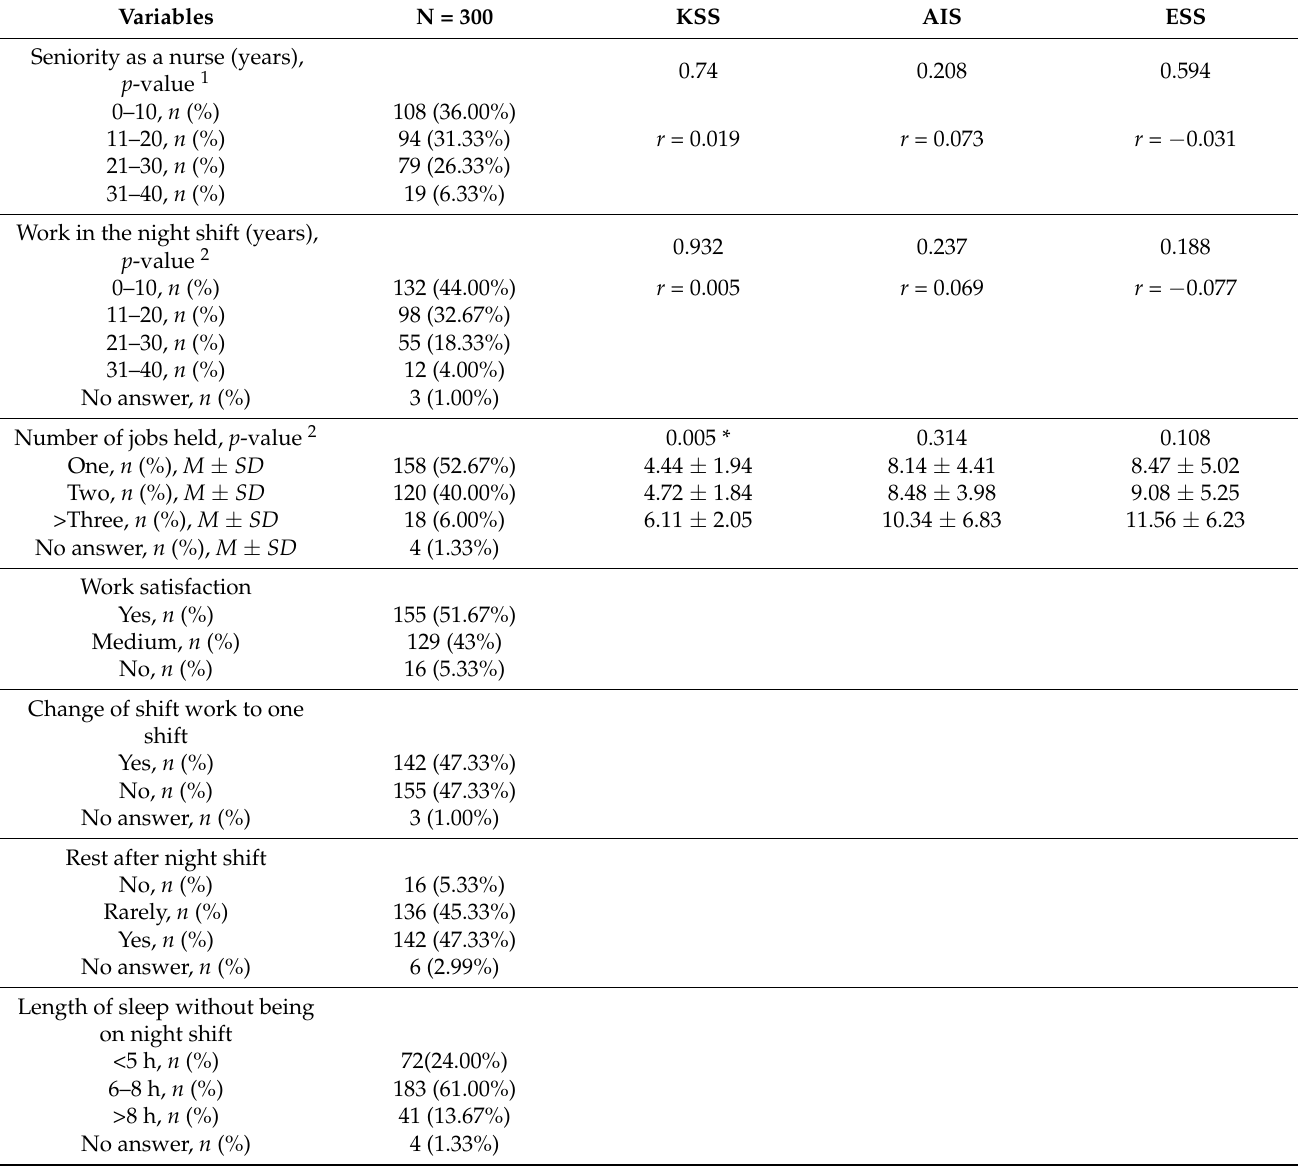
Table 2. Characteristics of work and sleepiness of the